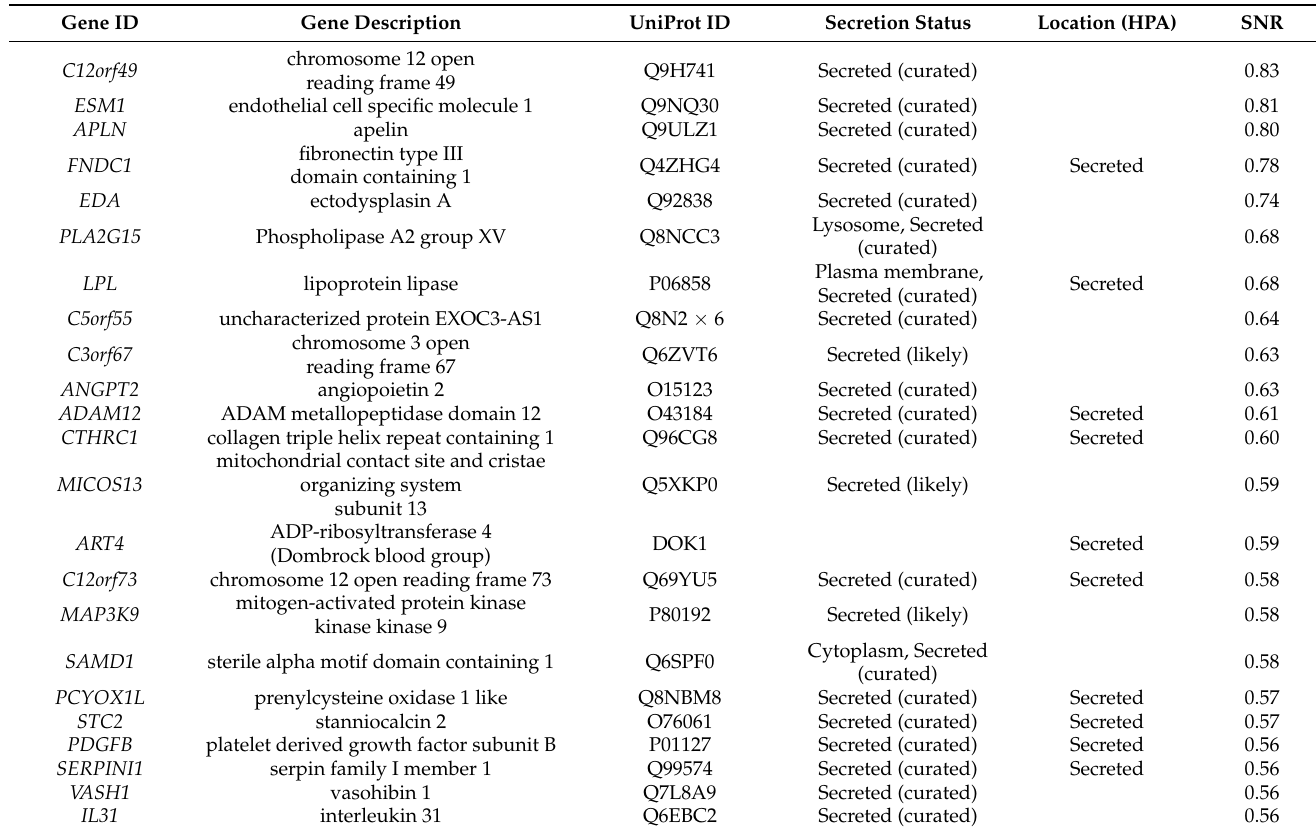
Table 2. List of the most highly upregulated (metastasis vs. PT) genes coding for secreted proteins. SNR = signal-to-noise ratio (Metastasis vs. PT); permutation p value for all genes =